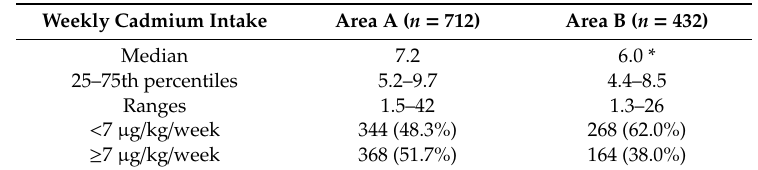
Table 13. Weekly cadmium intake per body weight (µg/kg BW/week) in female farmers in areas A and B and their distribution.